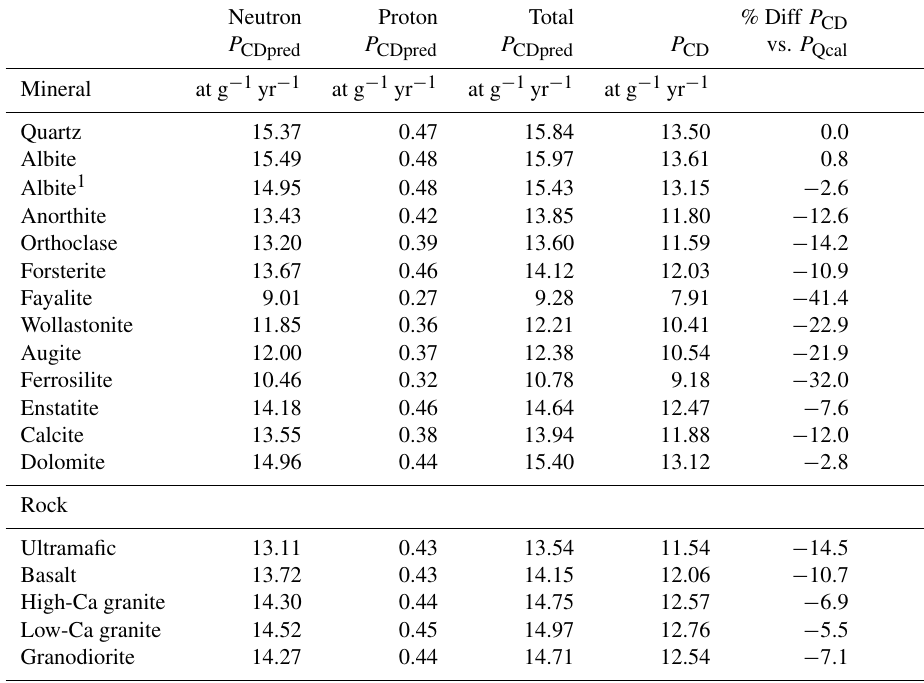
Table 2. Predicted modern in situ 14 C spallogenic production rates (atg − 1 yr − 1 ) at SLHL from neutrons and protons in minerals and rock types considered, both theoretical ( P CDpred ) and normalized to calibrated production in quartz ( P CD ) using the gridded R C record of Lifton